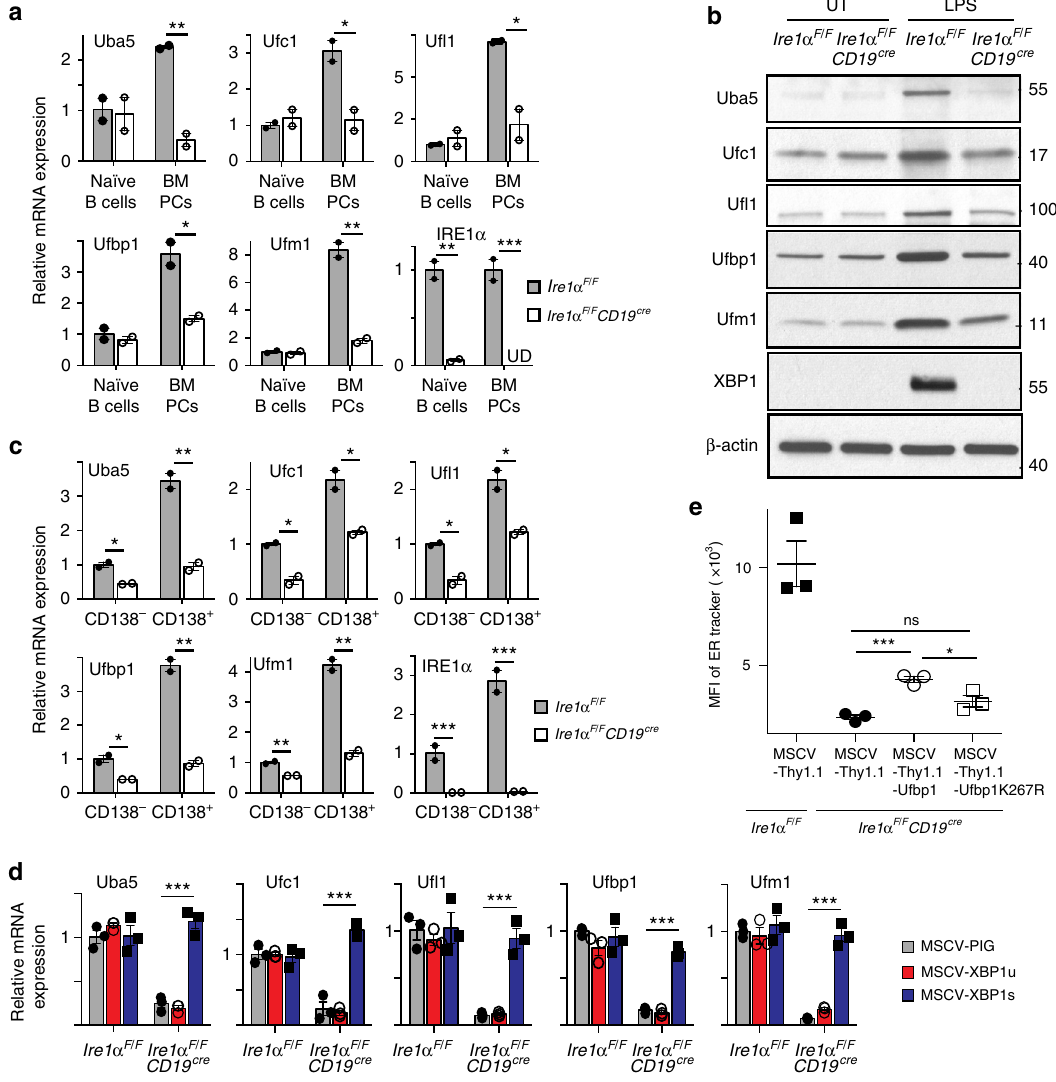
Fig. 7 Ufbp1 downstream to IRE1/XBP1 induces endoplasmice reticulum (ER) expansion. a Naive B cells and plasma cells were sorted from the spleens and bone marrows respectively of Ire1 α F/F and Ire1 α F/F CD19 cre mice. Expression of the indicated molecules normalized against β -actin was quanti fi ed